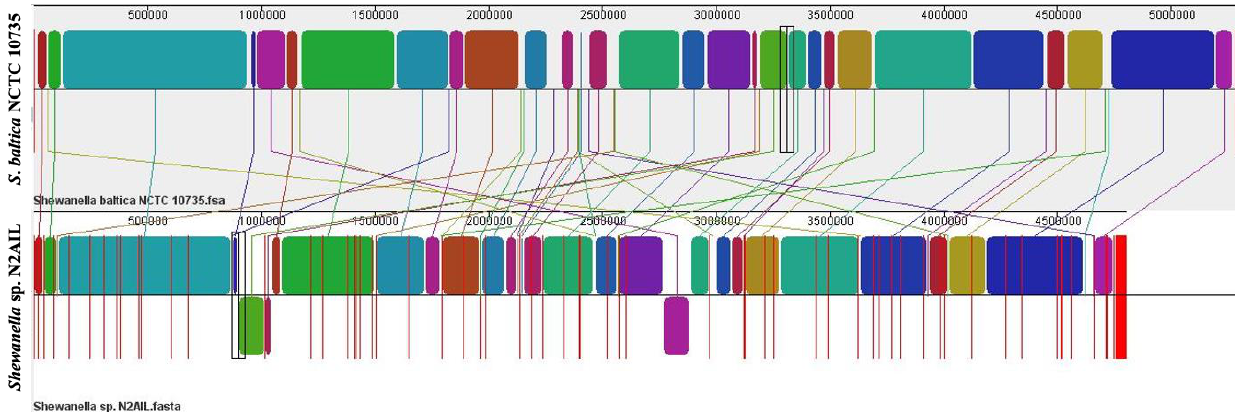
Figure 5. Genome alignment of Shewanella sp. N2AIL and S . baltica NCTC 10735 performed using MAUVE showed variation in genome structure. The scale shown above represents coordinates of each genome. LCB’s (Local Collinear Blocks) shown in different colours represented conserved segments in both the genomes. White area present within the LCB’s represents the regions with low similarity. LCBs shown above the central black horizontal line are in forward orientation and below are in reverse orientation. Coloured lines show rearrangements between two